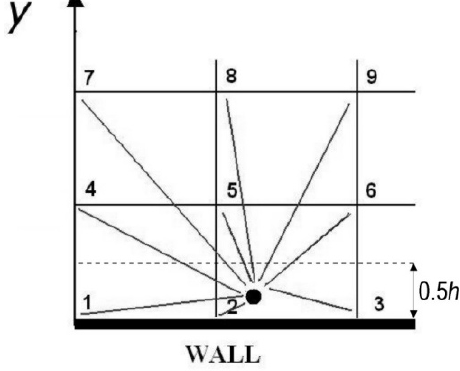
Figure 2. Remeshing of vortex particles close to the